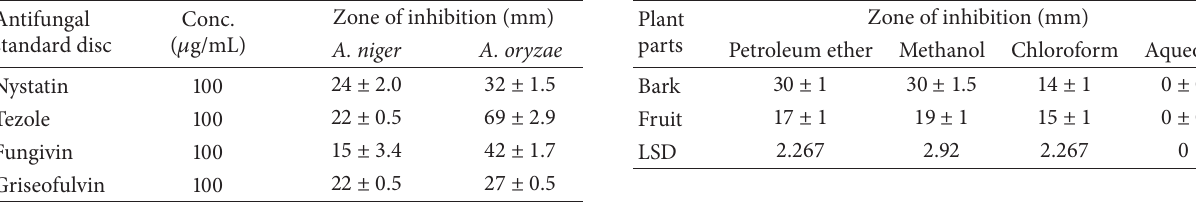
Table 5: Zone of inhibition produced by extracts of different parts of C. ambrosioides against P. aeruginosa.